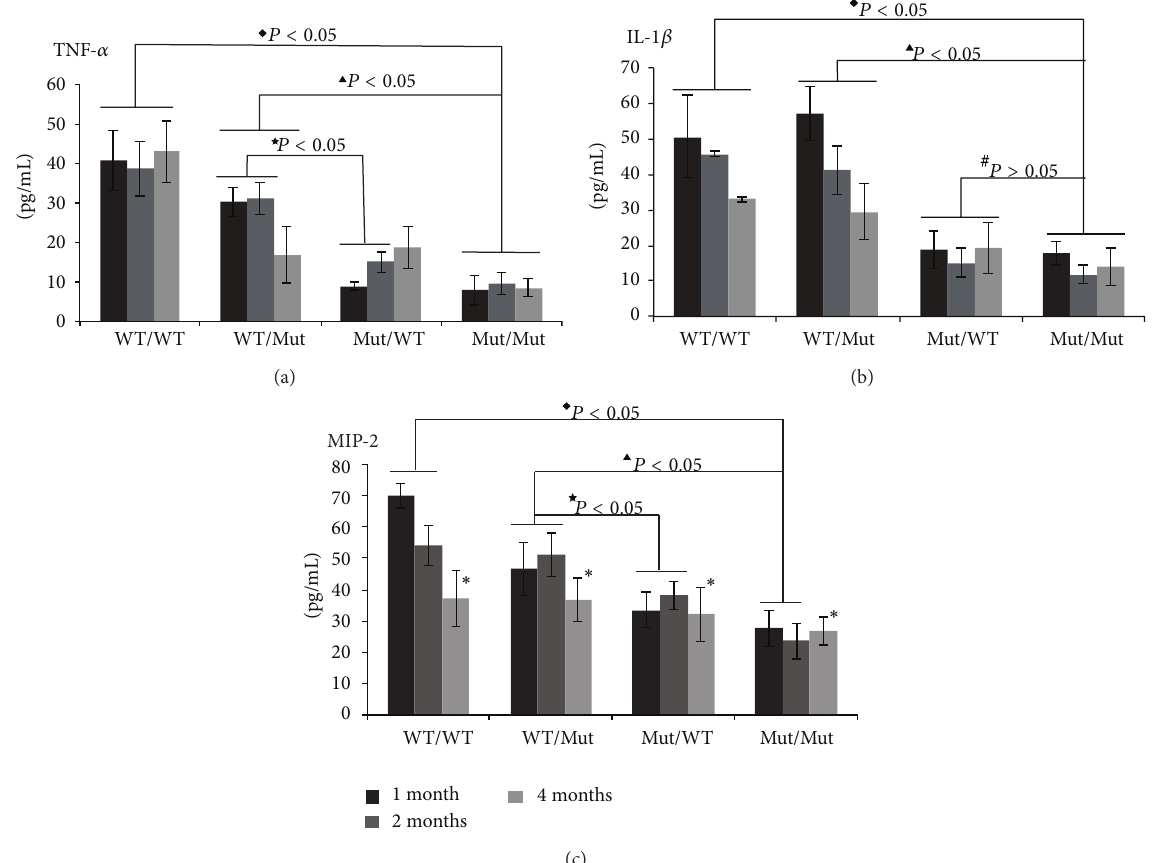
Figure 3: Levels of the inflammatory mediators TNF- 𝛼 , IL-1 𝛽 , and MIP-2 in whole retinas from each group as detected by ELISA. The data are represented as the means ± SE (4–6 mice per group). X 𝑃 < 0.05 , compared between WT/WT and Mut/Mut groups in the same time point; 󳵳 𝑃 < 0.05 , compared between WT/Mut and Mut/Mut groups in the same time point; 󳀅 𝑃 < 0.05 , compared between WT/Mut and Mut/WT groups in the same time point; # 𝑃 > 0.05 , compared between Mut/WT and Mut/Mut groups in the same time point; ∗ 𝑃 > 0.05 , ANOVA, compared among the four groups.